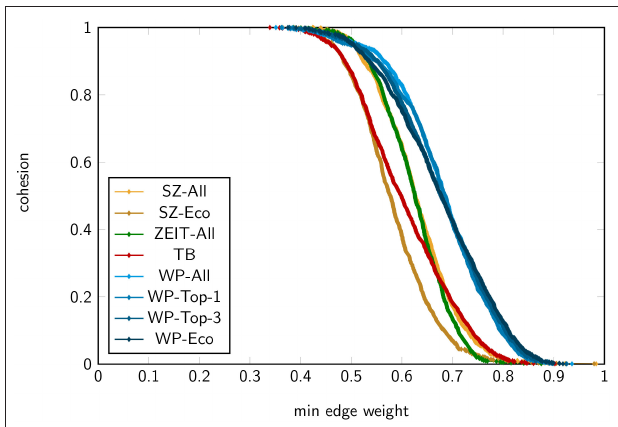
FIGURE 10 | Network clustering per α -cut ( α = minimal allowable edge weight) of word embedding networks of threshold concepts (TCNs) based on the cbow